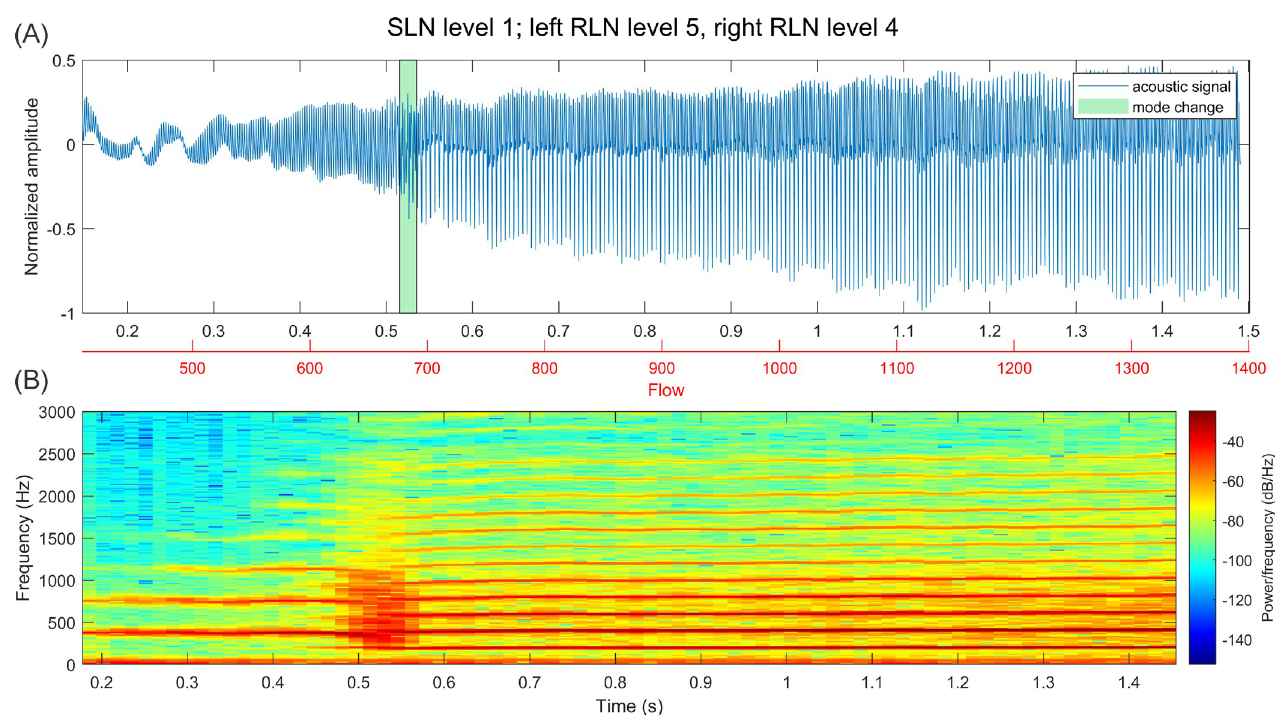
Fig 7. (A) Acoustic signal over period of stimulation with increasing flow and marked mode change (detected based on GAW LF0). (B) Spectrogram over same time period (4096 window length, 80%